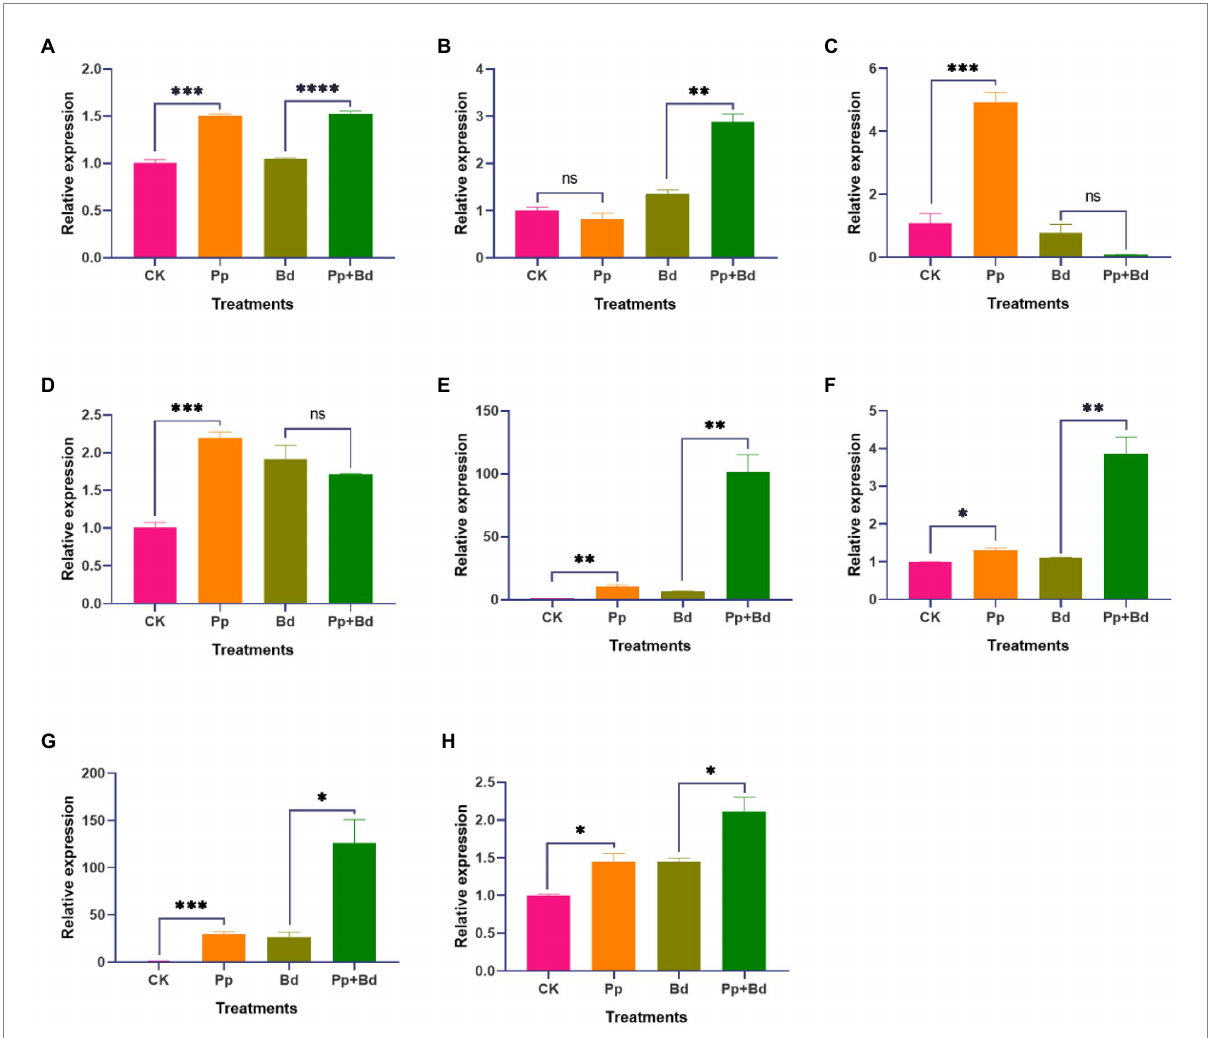
FIGURE 6 The relative expressions of various defense-related genes and the transcription factors, including MdGLU (A) , MdCATe (B) , MdPOD (C) , MdPAL (D) , MdPUB29 (E) , MdWRKY15 (F) , MdERF11 (G) and MdMYB73 (H) in various treated apple fruits. * p < 0.05, ** < 0.01, *** p < 0.001, **** p < 0.0001, ns p >